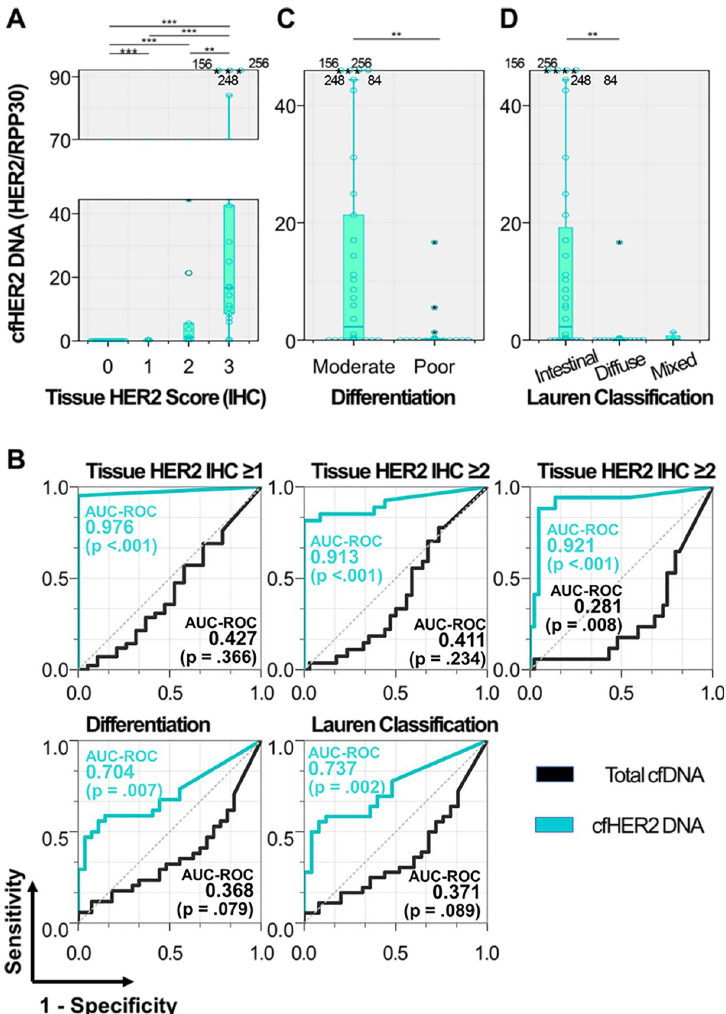
Fig 5. cfHER2 DNA detected from patients with malignant tumor. (a) HER2 expression in cfDNA depending on the tissue HER2 score. HER2 expression (b) ROC curve analysis demonstrating the correlation of cfHER2 DNA expression with tissue HER2 score, cell differentiation, and Lauren classification. (c, d) HER2 expression in cfDNA depending on (c) cell differentiation and (d) Lauren classification.